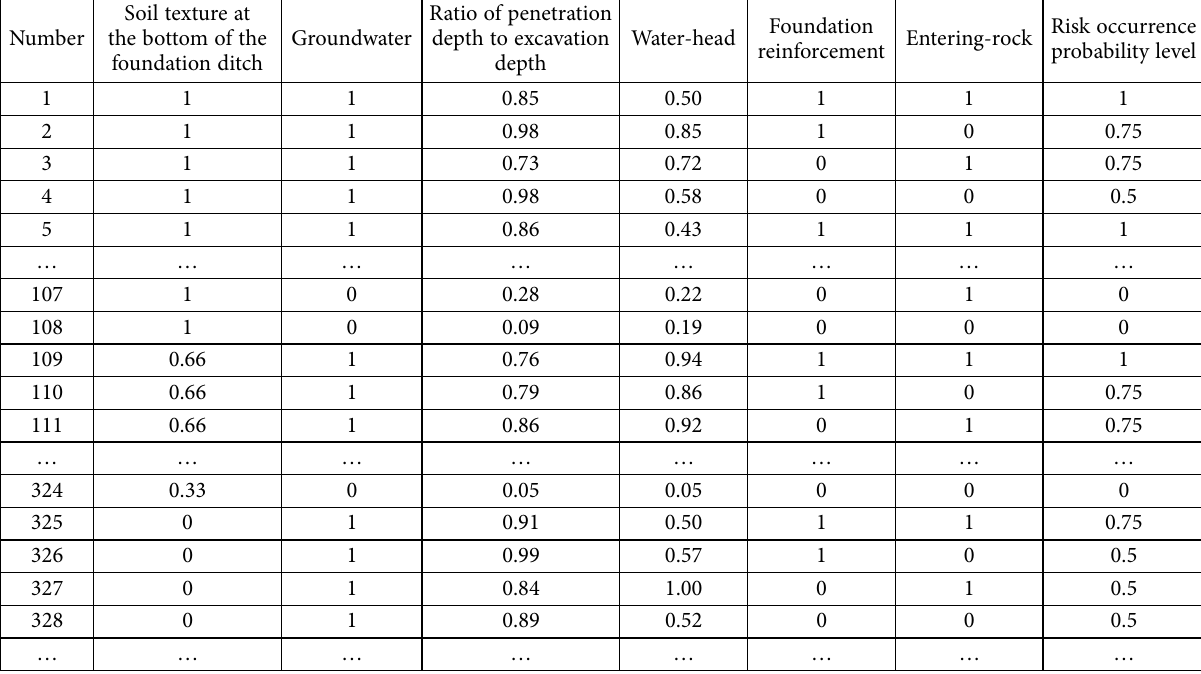
Table 9. Knowledge Information system for the risk evaluation of water and sand gushing in the foundation pit bottom Soil texture at Number the bottom of the